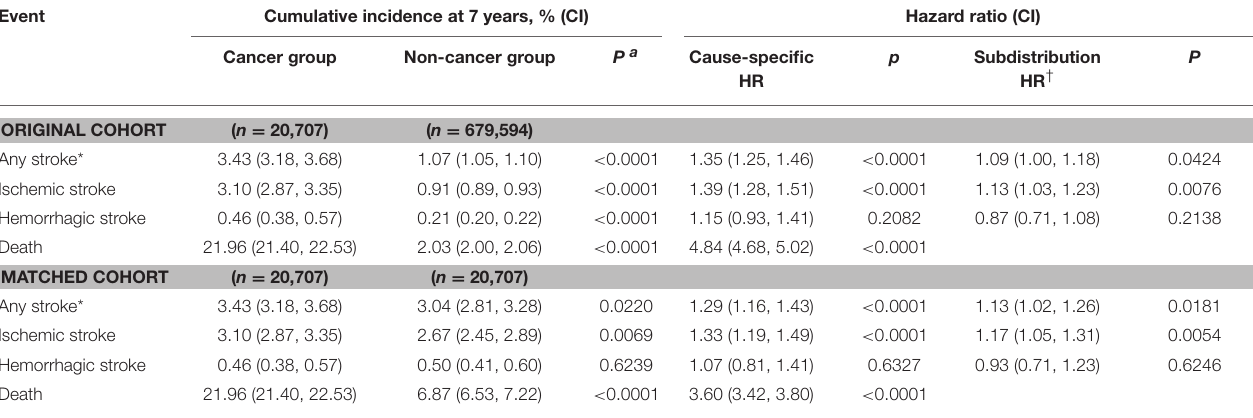
TABLE 2 | Cumulative incidence and relative hazard of each event in subjects with and without cancer at the end-of-study (after 7 years).